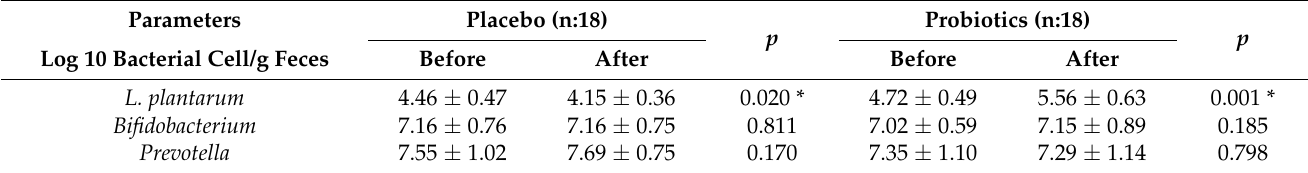
Table 7. Specific bacteria analyzed by PCR.